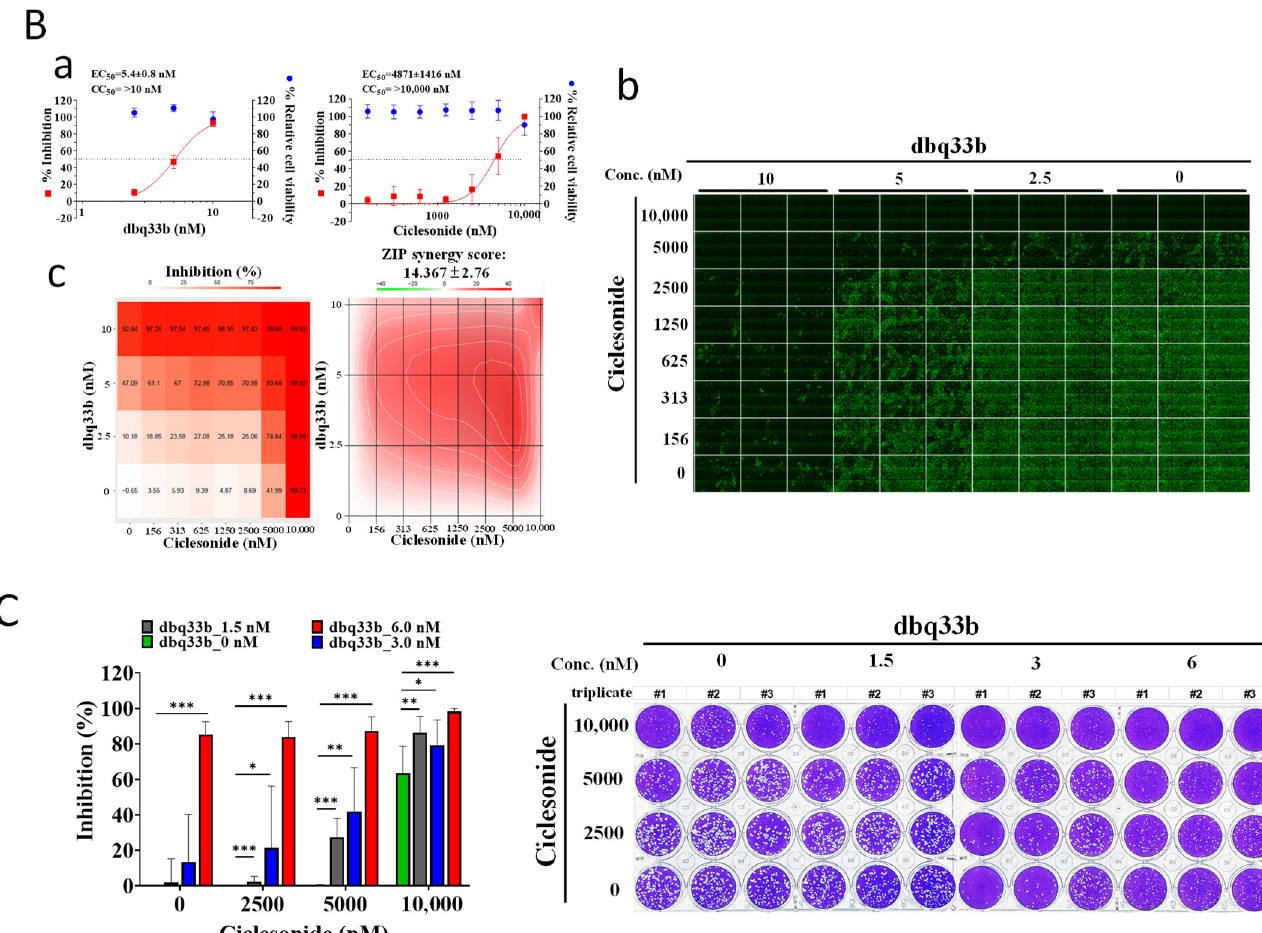
Figure 6. Combined treatments of ciclesonide and tylophorine-based dbq33b synergistically inhib- ited coronaviral replication. ( A ) Combined treatment of ciclesonide and tylophorine-based dbq33b synergistically inhibited HCoV-OC43 infection/replication in human fetal lung fibroblast MRC-5 cells assayed by IFA. ( B ) Combined treatment of ciclesonide and tylophorine-based dbq33b synergistically inhibited SARS-CoV-2 infection/replication in Vero E6 cells assayed by IFA. ( C ) Combined treatment of ciclesonide and tylophorine-based dbq33b synergistically reduced infectious SARS-CoV-2 viral loads as determined by plaque formation assays. IFAs were performed with antibody against viral N protein (green) in HCoV-OC43-infected MRC-5 (0.05 MOI) at 30 h.p.i. treated with vehicle (0.5% DMSO) or compounds as indicated. Nuclei (blue) were counterstained with Hoechst dye and used to determine the relative cell viability by using the number of nuclei in vehicle control as 100%. The Methods used for IFA and plaque assays for SARS-CoV-2 infectivity in Vero E6 cells were performed and analyzed as described [5]. The effects of single treatments within indicated concentrations were shown as AVE ± S.D. from three independent experiments ( Aa , Ba , C ). IFA or plaque formation images ( Ab , Bb , C ) shown are representative of three independent experiments. (* p < 0.05, ** p < 0.01, *** p < 0.001). Shown synergy scores are AVE ± S.D. from three independent